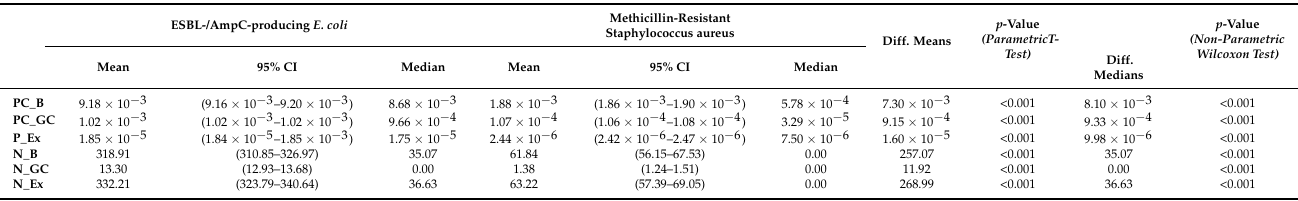
Table 4. Comparative analysis of consumer exposure between methicillin-resistant Staphylococcus aureus and ESBL- /AmpC-producing E.